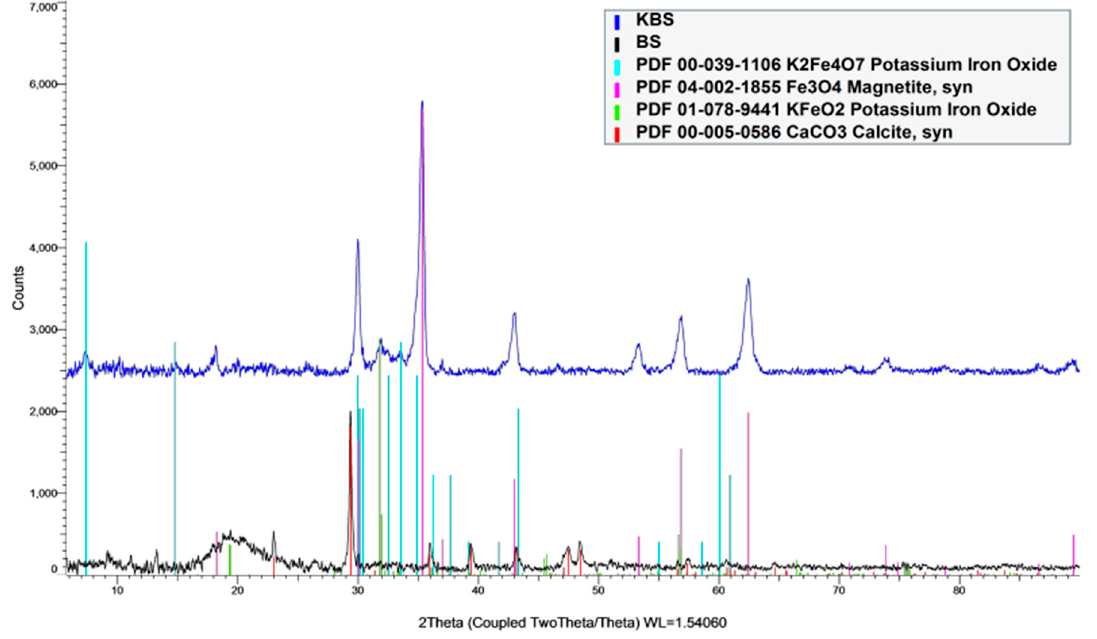
Figure 3. XRD results of of bothpristine (BS) and aactivated samples (KBS) .